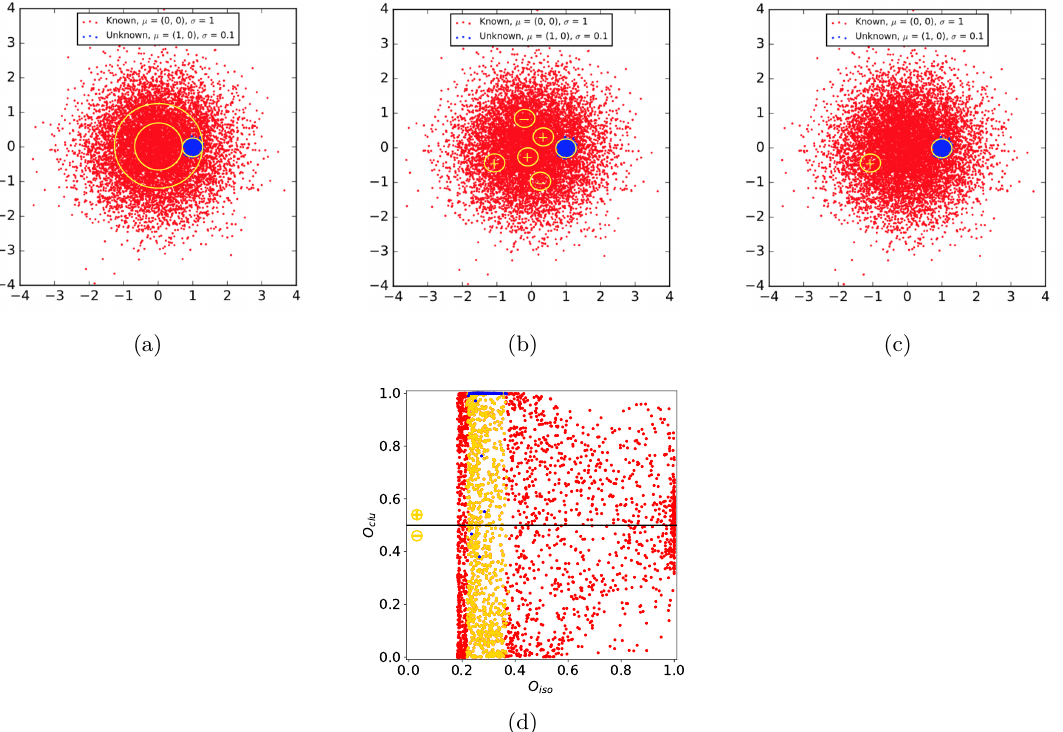
Figure 1 . Cartoon illustrating the response of different types of novelty evaluators in the case of a 2D Gaussian example, consisting of 10000 background events (red points) and 1000 signal events (blue points). In the case of O evaluators, the backgrounds are mainly from the ring band between iso two yellow circles in (a). In contrast, O evaluators are affected by the upward fluctuations in clu the local density of background events, denoted by the areas within the yellow-plus circles in (b) (downward fluctuations are denoted by the yellow-minus circles). A synergy-based evaluator, O , syn would be affected only by the upward fluctuations in local density that lay within the ring band, as illustrated in (c). The distribution of the O vs. O responses is shown in (d), where yellow clu iso points represent the background events within the yellow circle in (a), and the red points are the rest of background events. Exploiting the information encoded in both evaluators would clearly allow to improve the signal sensitivity by suppressing the backgrounds described